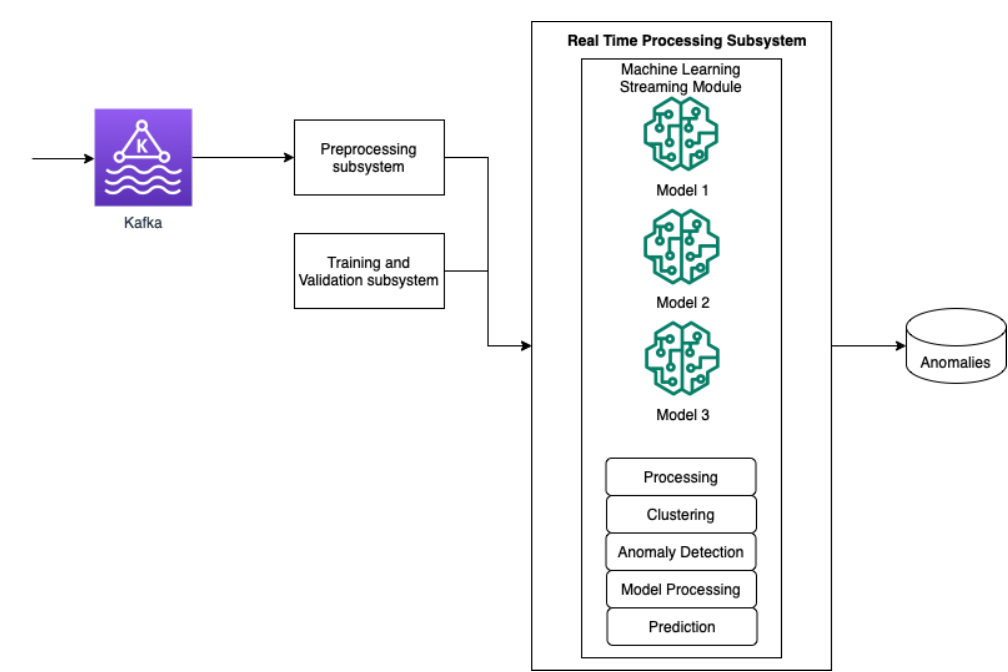
Figure 10. Modular architecture of the real time processing